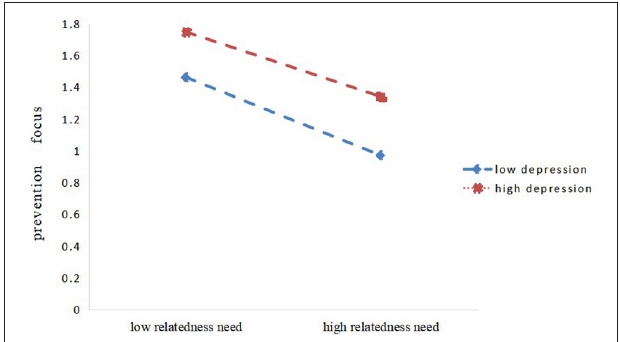
FIGURE 2 | Depression moderates relatedness need satisfaction and prevention focus.